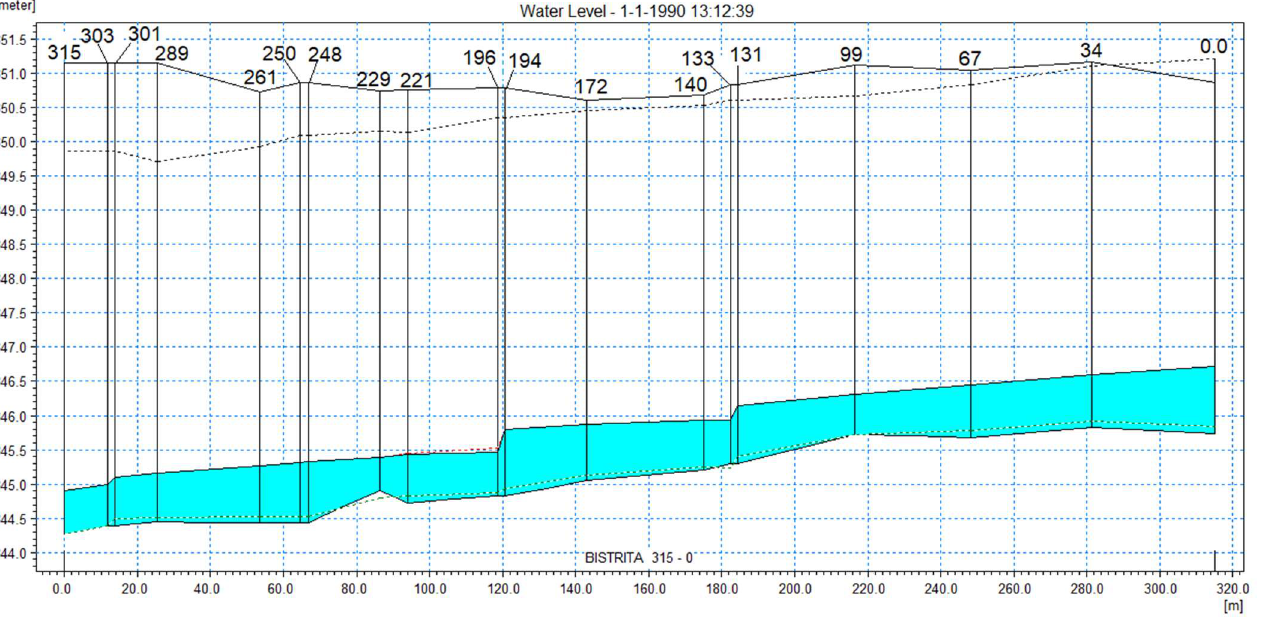
Figure 14. Water level for flow Q = 8.37 m 3 /s, the average annual flow calculated for the year 2021. For the proposed case with the lowering of the crest of the existing weir and the construction of three new weirs of low height downstream of it.